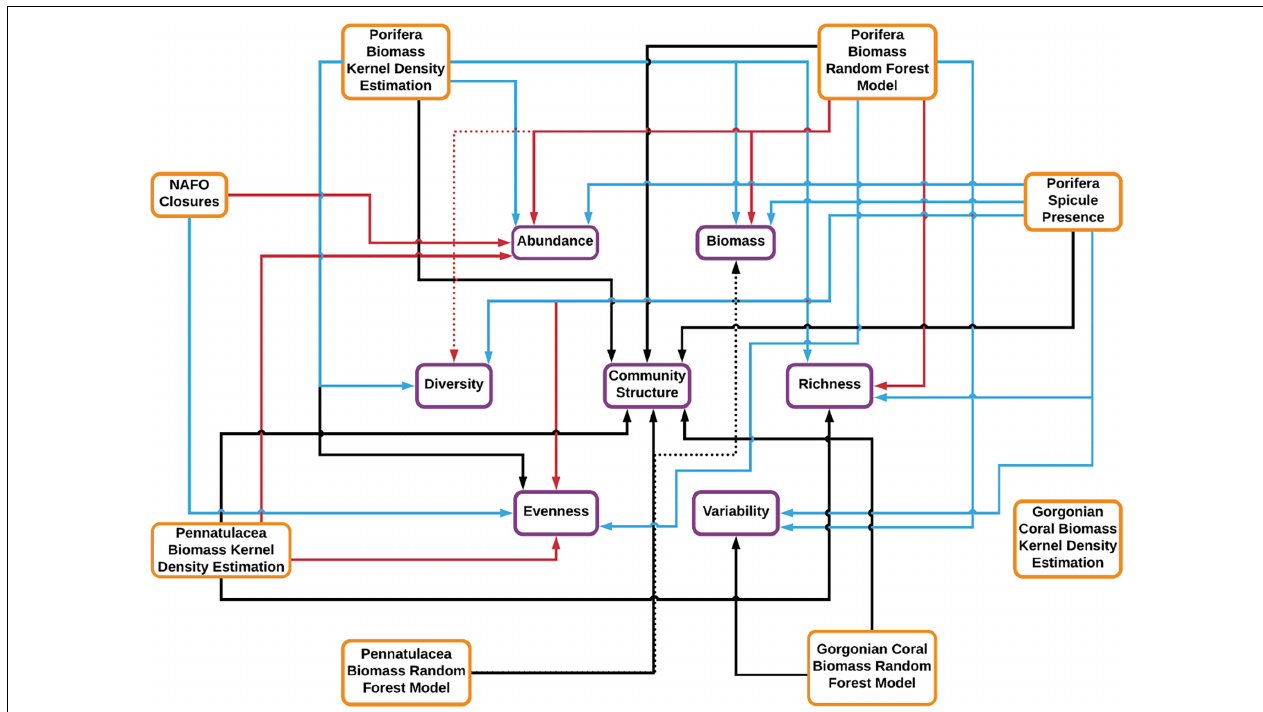
FIGURE 4 | Summary diagram detailing the influence of VME-indicator taxa on the benthic peracarid fauna of the NAFO Regulatory Area, and whether fishery closures host distinct peracarid assemblages or not. Links between environmental parameters (orange boxes) and biological parameters (purple boxes) are specified. The colour of the arrow represents the form of relationship: blue, positive; red, negative; black, complex (e.g., “U” shaped or uni/multi-modal). Solid arrows represent significant relationships ( P < 0.05). Dotted arrows represent marginal relationships ( P < 0.1).